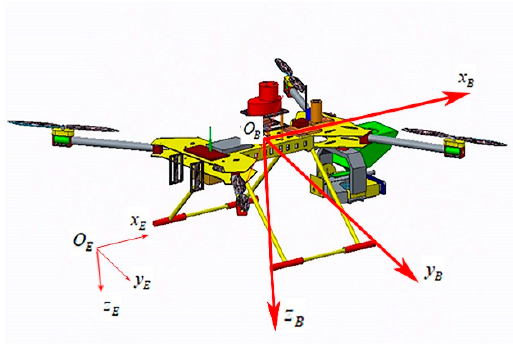
Figure 5. Quadcopter coordinate system.